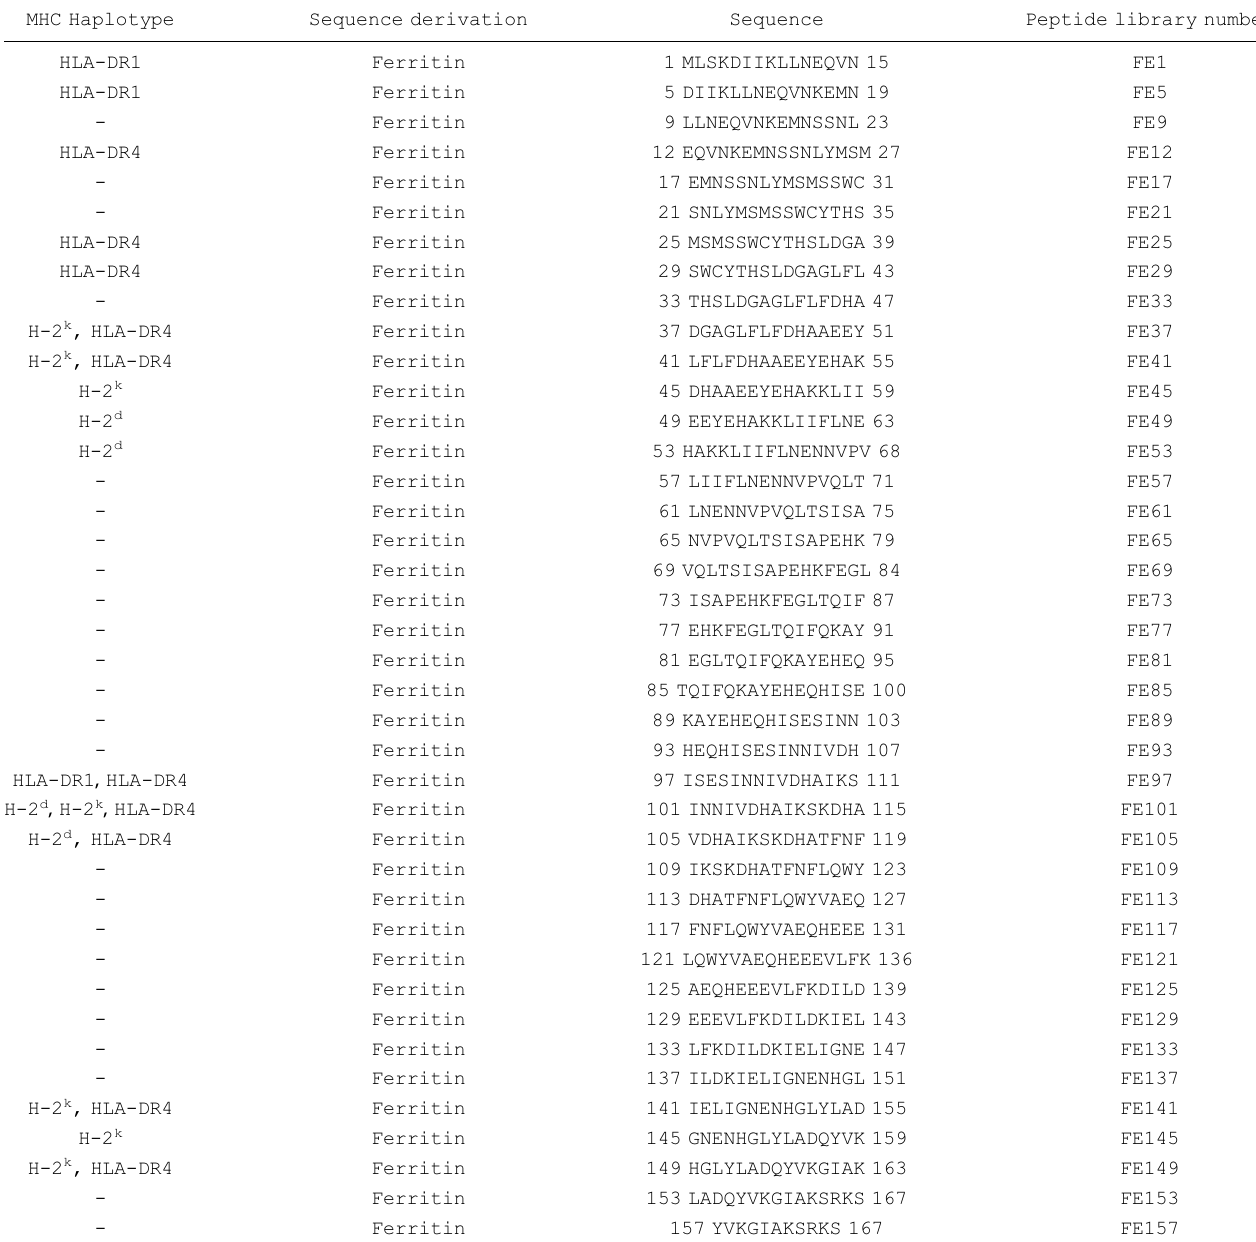
Table 1. MHC Class II-restricted H. pylori ferritin epitopes in H-2 d , H-2 K , HLA-DR1, and HLA-DR4